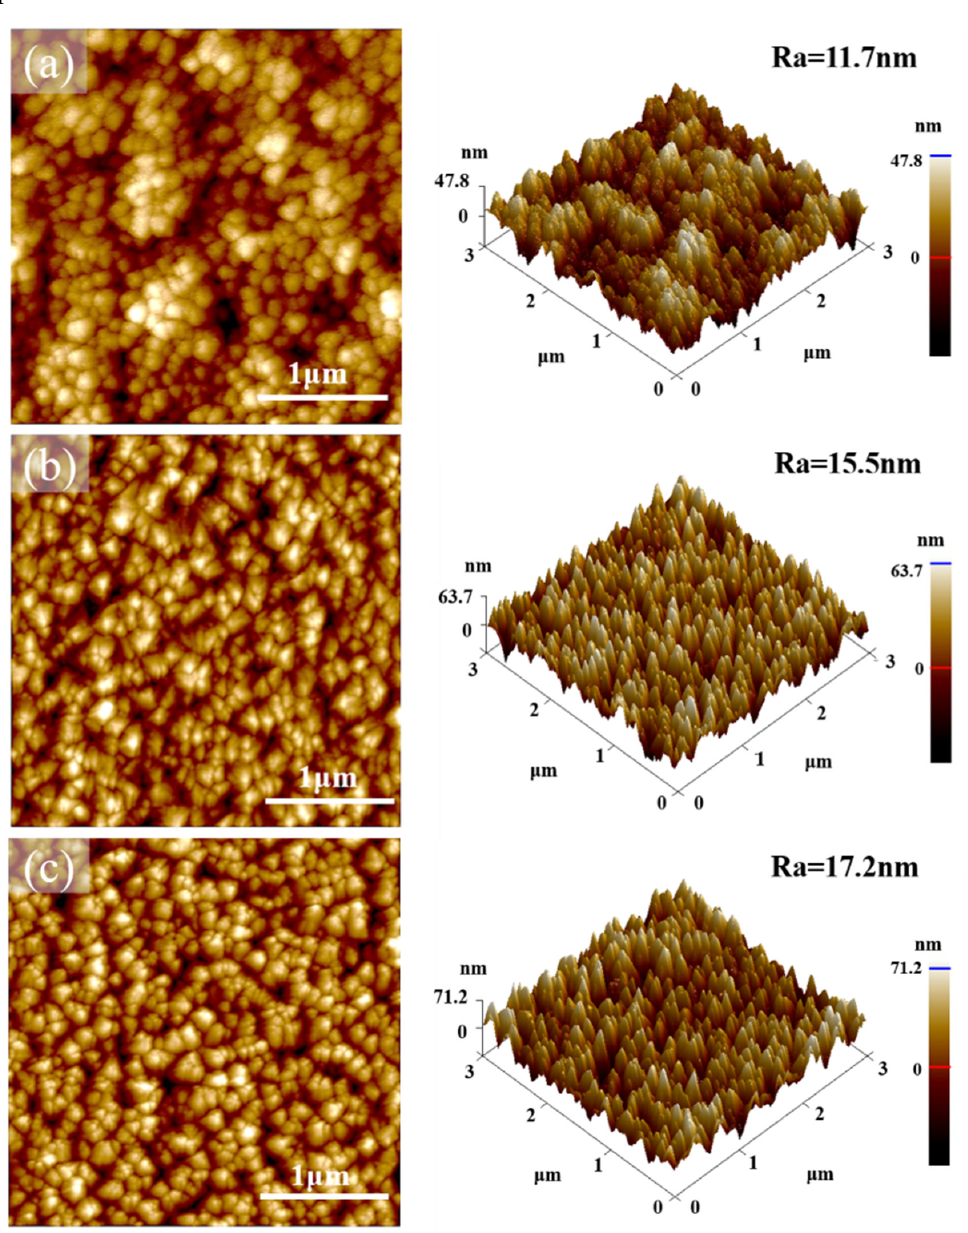
Figure 7. AFM analysis for topographic images of CrN films deposited of ( a ) 2 h, ( b ) 2.5 h, and ( c ) 3 h, respectively.